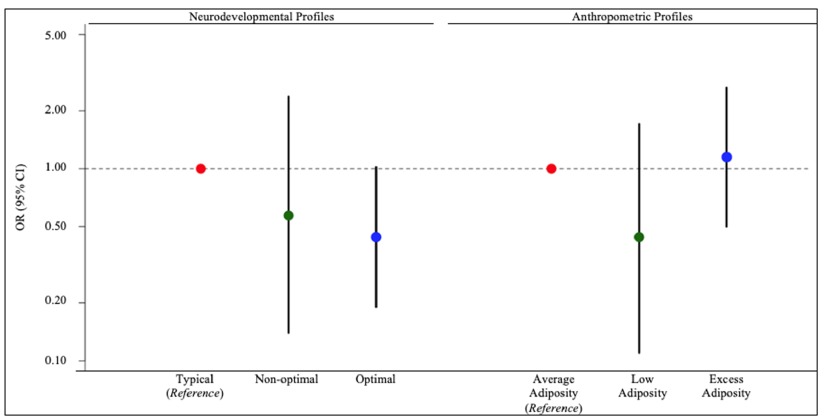
Figure 2. Adjusted associations of neurodevelopmental and anthropometric phenotypic profiles with maternal first trimester log 10 -transformed urinary DMA concentrations ( μ g As/L ) among MIREC study participants. MIREC: Maternal–Infant Research on Environmental Chemicals; DMA: dimethylarsinic acid. For descriptive information of phenotypic profiles, see Supplementary Table S1. Models adjusted for maternal age at delivery (continuous), maternal birth country (Canada or foreign), prenatal multivitamin use (yes or no), maternal depressive symptoms (continuous CES-D scores), maternal pre-pregnancy BMI (normal/underweight or overweight or obese), income (continuous), and parity (nulliparous, one previous child, two or more previous children). Error bars represent 95% confidence intervals. Note, the y-axis is on the log scale.